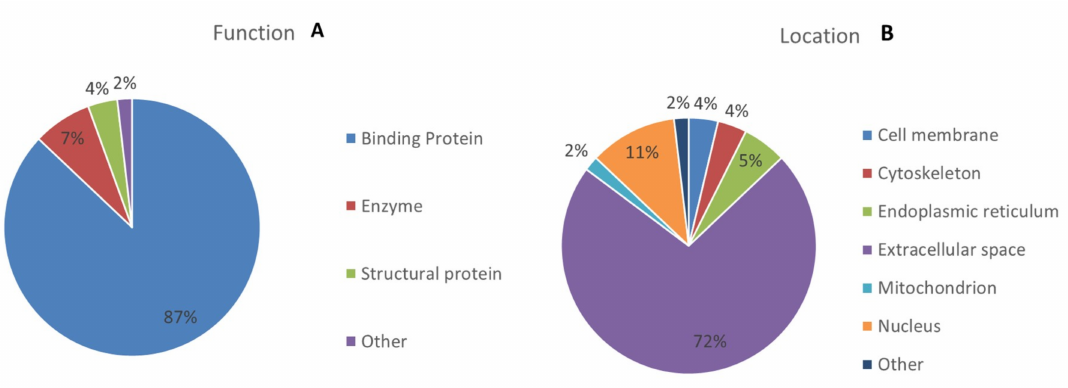
Figure 5. Comparative depiction (%) of identified proteins categorized into groups according to their function ( A ), and cellular component ( B